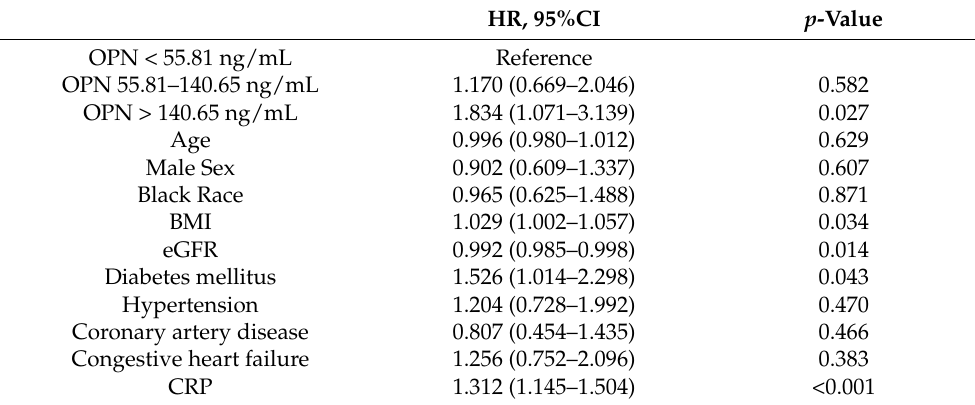
Figure 3. Kaplan-Meier curve estimates for the composite endpoint. COVID-19 patients with initial OPN levels in the lower tertile have a significantly better event-free survival regarding the composite endpoint (either death, need for mechanical ventilation or need for renal replacement therapy). Table 5. Cox regression analysis for the prediction of the combined endpoint (either death, need for mechanical ventilation, or need for renal replacement therapy).